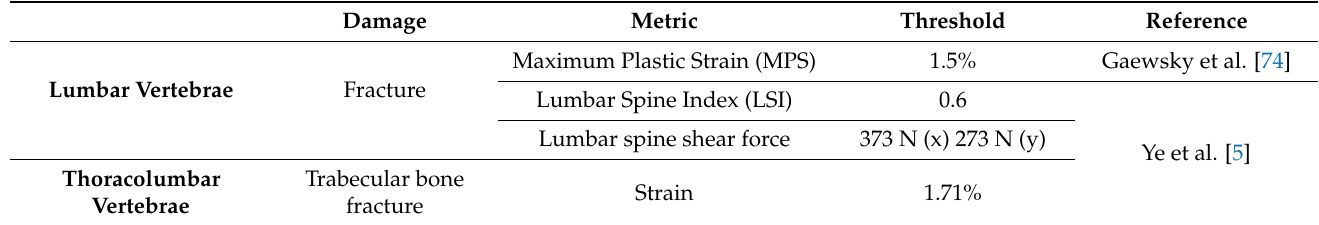
Table 3. Summary of the main proposed IC for the spine and the